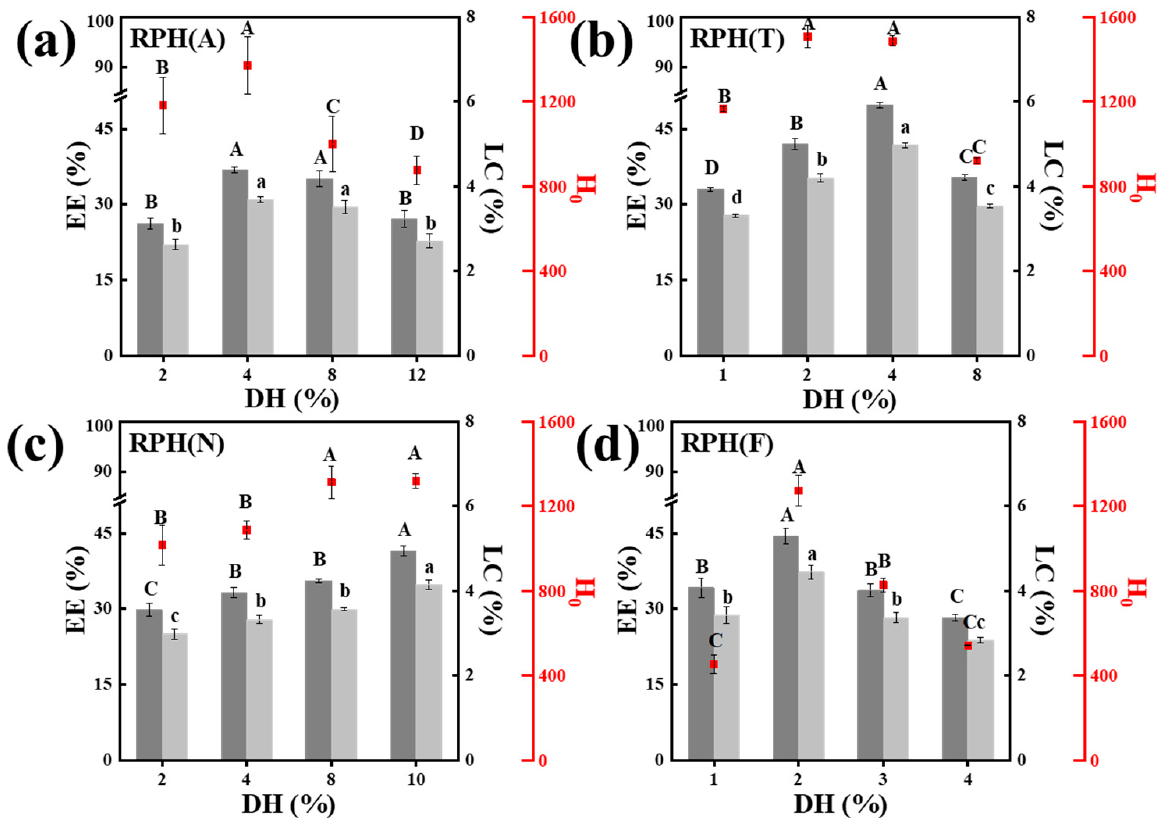
Figure 1. The encapsulation efficiency (EE) and loading capacity (LC) of rice protein hydrolysate soy isoflavone (RPH-SIF) nanoparticles at different degrees of hydrolysis (DH) of RPHs (( a ): RPH(A), ( b ): RPH(T), ( c ): RPH(N), and ( d ): RPH(F)), the hydrophobicity (H 0 ) of RPHs with different DHs. A–D Different superscript letters represent a significant difference ( p < 0.01). a–d Different superscript letters represent a significant difference ( p < 0.05).